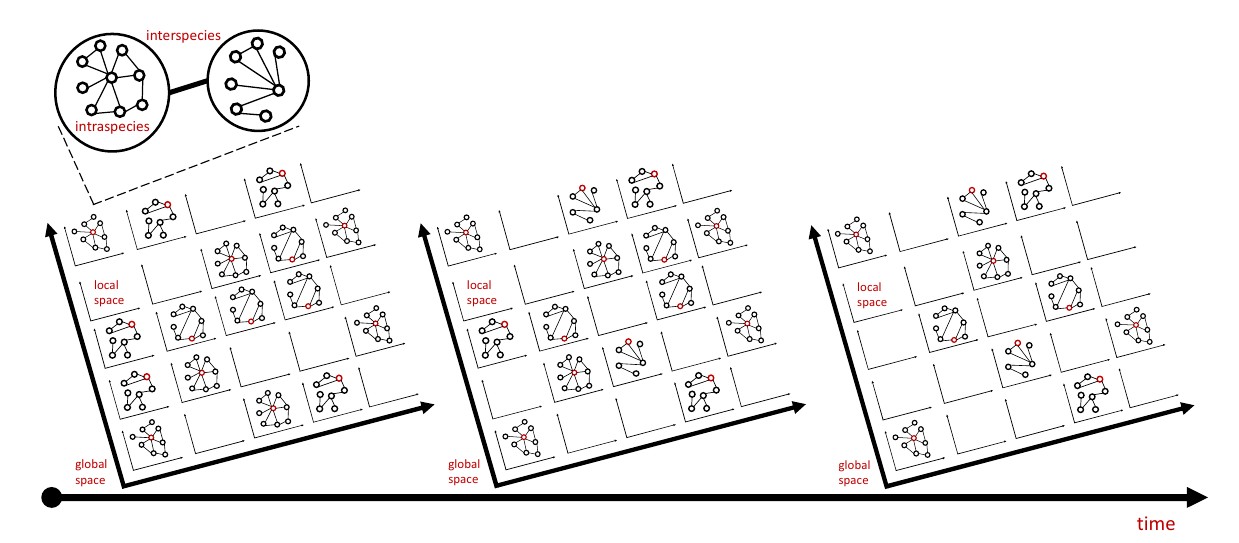
Figure 3. Multiscale investigation of overdispersion. At the top part of the figure, overdispersion can happen at the species population network and also at the interspecies (or intercommunity) net- work. Food chain or web, predation, parasitism, and other interactions can characterize interspecies network. At the middle part of the figure, overdispersion can be investigated at a certain locality and at the macroscale (global) spatial level. Spatial investigation can be analyzed using a grid sys- tem, depending on the availability of data and on the spatial homo/heterogeneity of the interaction networks. For simplicity, a 2D spatial representation is presented here, but a 3D representation can also be performed. Moreover, spatial overdispersion can be dynamic through time. The distribution of parasites in host population can vary and evolve spatially and temporally.